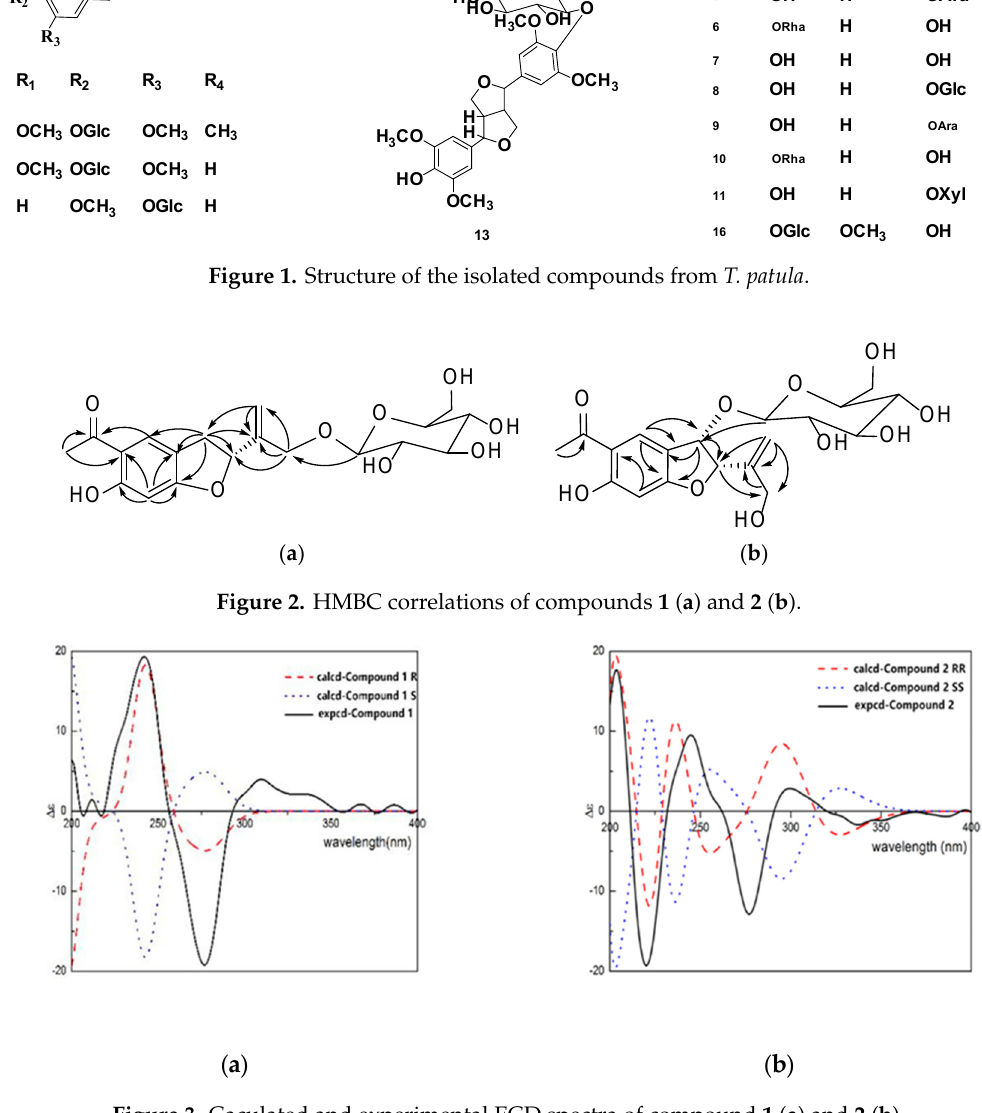
Figure 3. Caculated and experimental ECD spectra of compound 1 ( a ) and 2 ( b ).